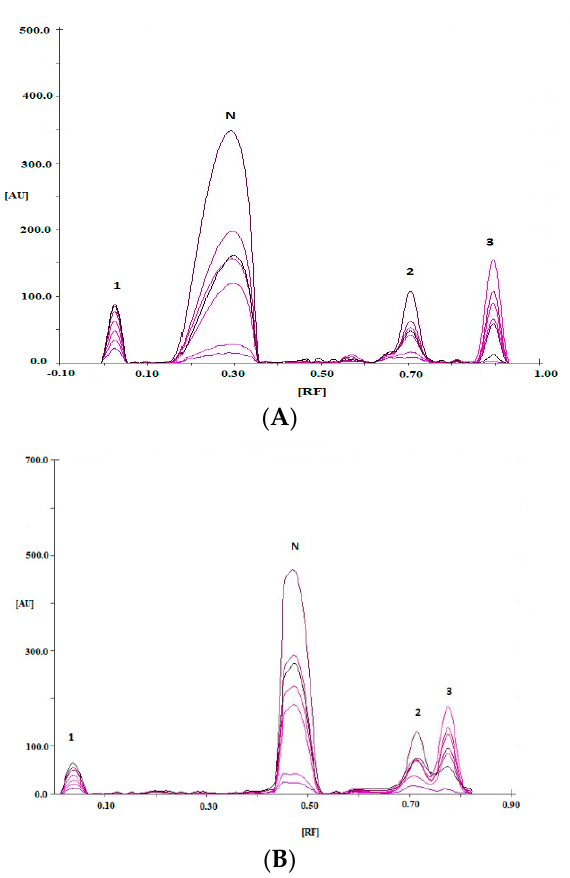
Figure 2. Densitogram of naproxen irradiated on silica gel with UV light at λ = 254 nm for a period of 5 h using a mobile phase: ( A ) TOL-ACE-CHL in a volume of 2:5:12, ( B ) AcOH-Hex-ACE in a volume of 0.10:10:10.